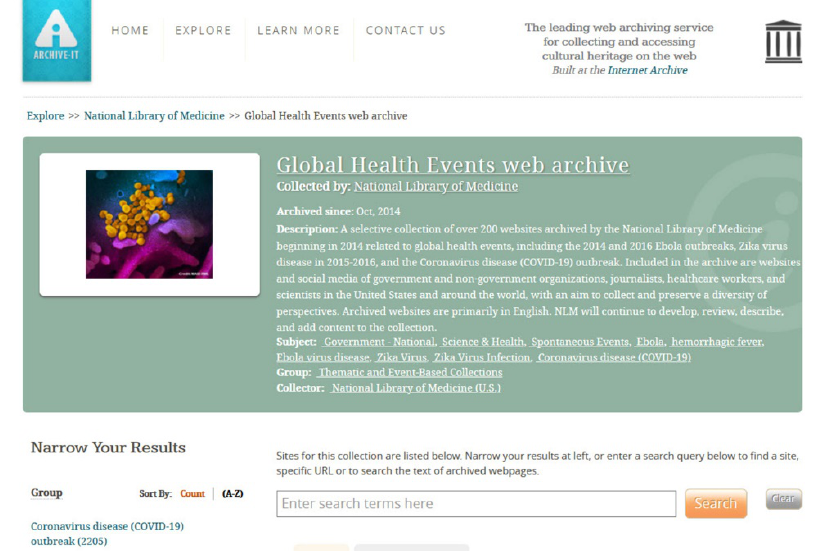
Figure 1 National Library of Medicine Global Health Events web